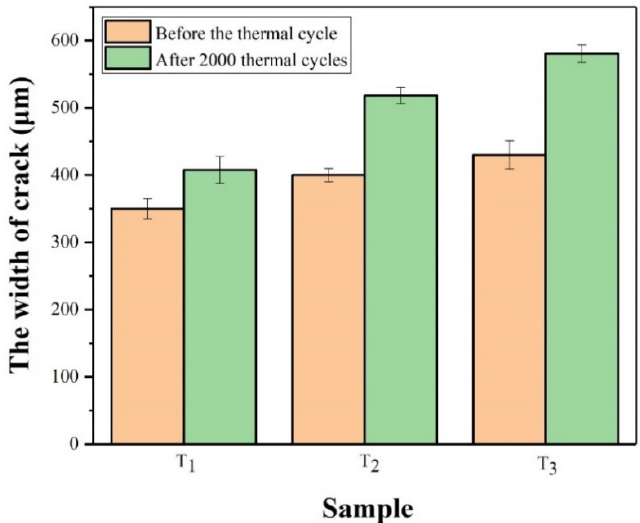
Figure 15. The change of cracks width of sample T 1 , T 2 , and T 3 . ( a , b ) Sample T 1 ; ( c , d ) sample T 2 ; ( e , f ) sample T 3 . ( a , c , e ) 0 thermal cycles; ( b , d , f ) 2000 thermal cycles.